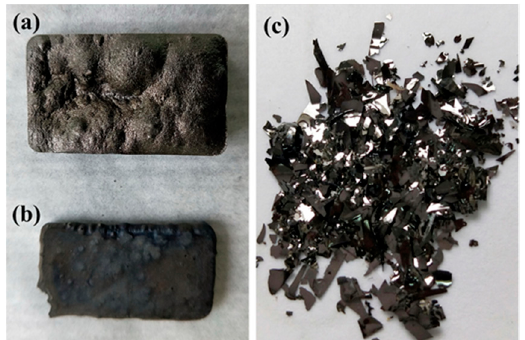
Figure 5. The photographs of GMC samples prepared in this study. ( a ) The GMC sample prepared at